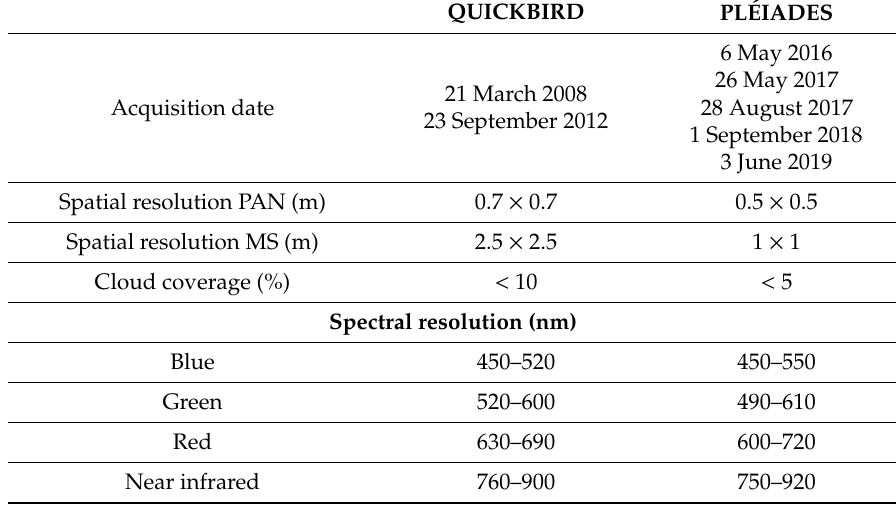
Table 3. Technical characteristics of satellite sensor and high-spatial-resolution (HSR) images used for this